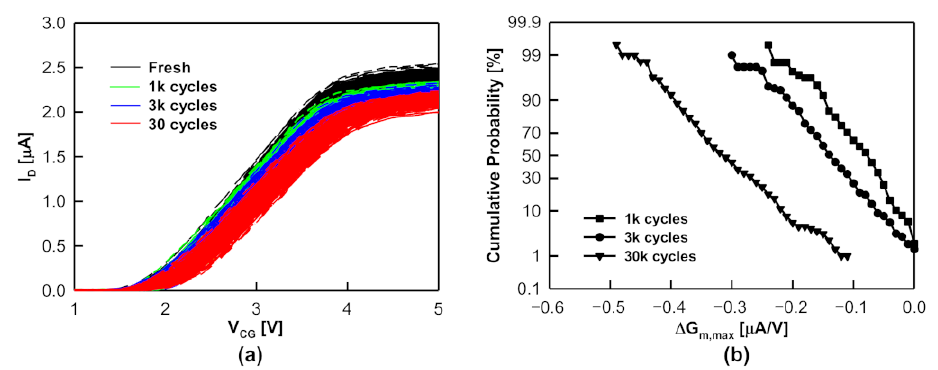
Figure 5. ( a ) I D − V CG Characteristics and ( b ) cumulative ∆ G m , max statistics of the read cells on WL15 as a function of the number of P/E cycles. Adapted from